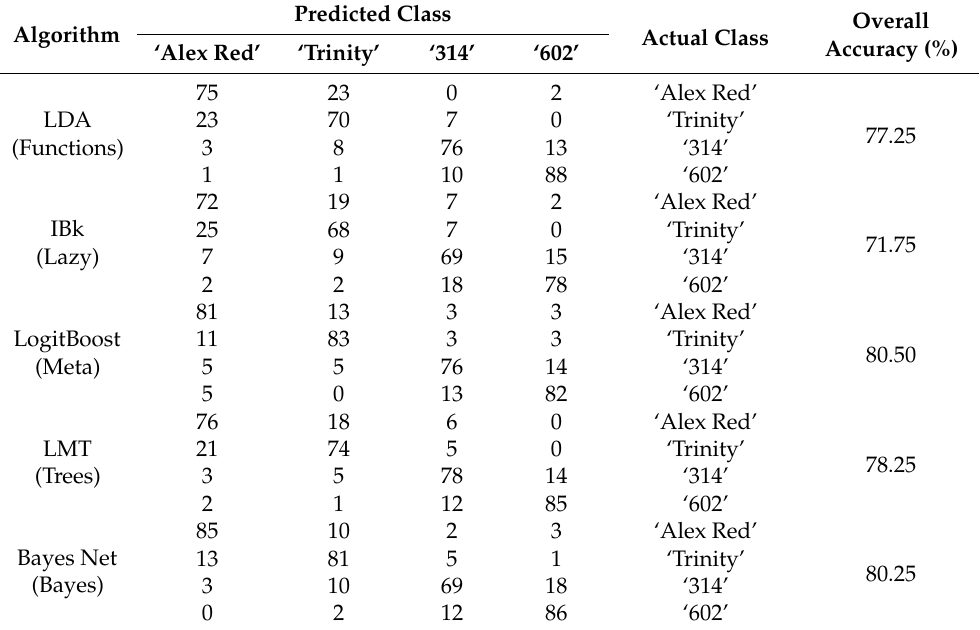
Table 8. The number of correctly and incorrectly classified cases and overall accuracies from distin- guishing freeze-dried red-fleshed apple cubes based on selected image textures and color parameters.